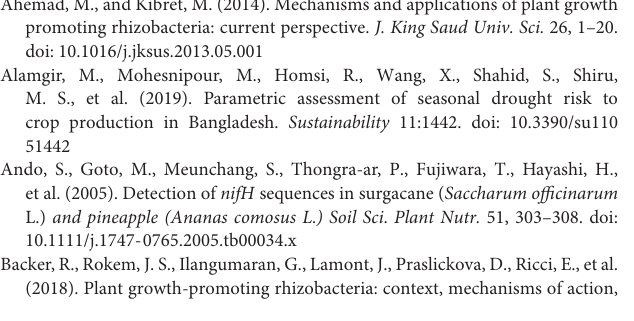
and lane 7-11 used KAD3F and DVVR primers pair. Supplementary Figure 3 | Qualitative ammonia production by different rhizobacterial strains. The 50 µ L (10 8 CFU mL − 1 ) culture were inoculated in the glass test tubes containing 5 mL peptone water and incubated at 28 ◦ C for 72 h. Then 1 mL Nessler’s reagent was added. Development of yellow to brown color indicated positive results. Supplementary Figure 4 | Qualitative production of HCN. Rhizobacterial strains were streaked on LB agar plates containing 0.45% glycine. Then filter papers dipped in alkaline pirate solution and placed on the lids of petri plates, sealed with parafilm and incubated at 28 ◦ C for 24 h. Positive HCN production resulted in a color development from yellow to reddish-brown. Supplementary Figure 5 | Production of biofilms by some selected rhizobacterial strains after 72 h incubation at 28 ◦ C in stationary condition. Biofilm formation on SOBG without 25% PEG 6000 (A) and SOBG with 25% PEG 6000 (B)